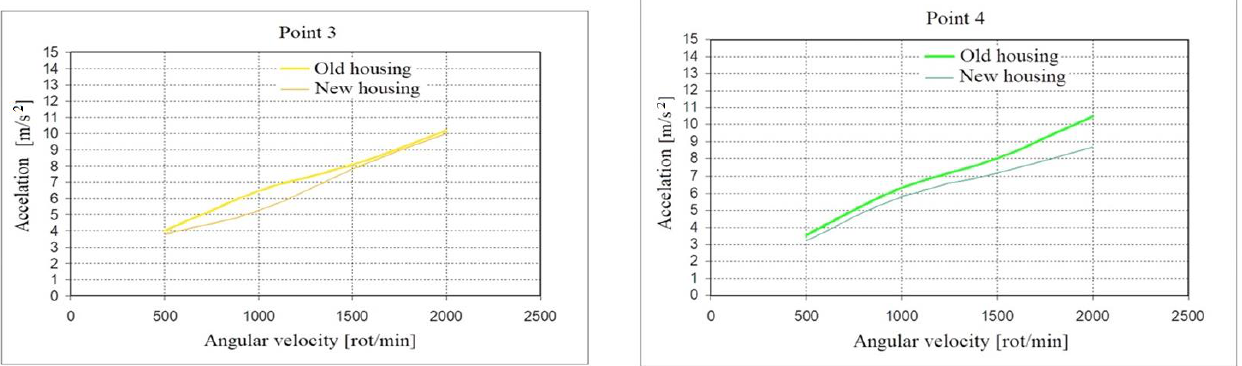
Figure 22. Measured accelerations at points 3 and 4 for the two versions (old and new).